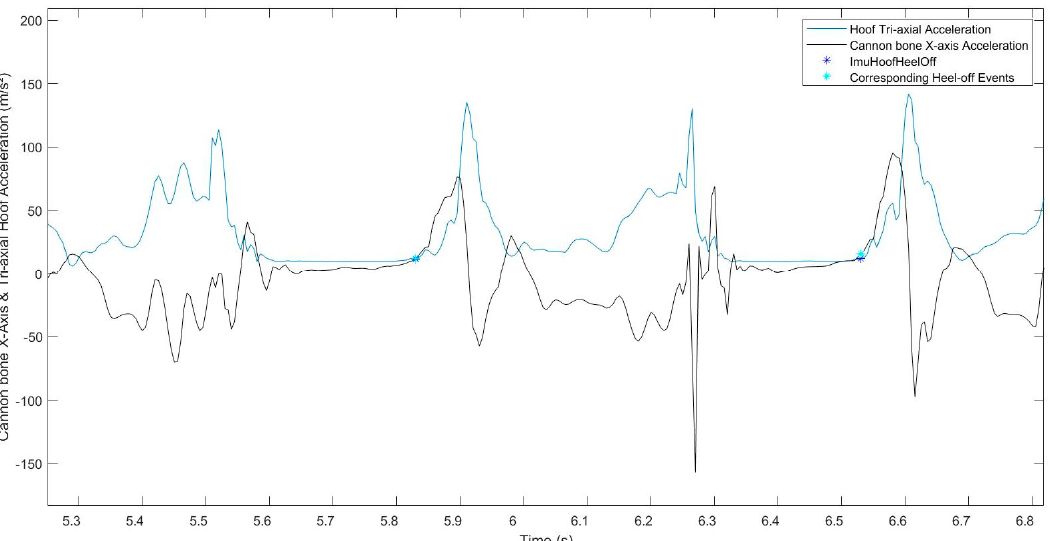
Figure 5. Representation of the hoof tri-axial acceleration (blue curve) and the cannon bone x -axis acceleration (black curve), for the “forelimb inside the circle” condition. The blue points correspond to the reference heel-off, and the cyan points correspond to the detected heel-off (from the cannon bone IMU data). Unlike all the other conditions, the cannon bone x -axis acceleration shows only one peak at the foot-off moment.